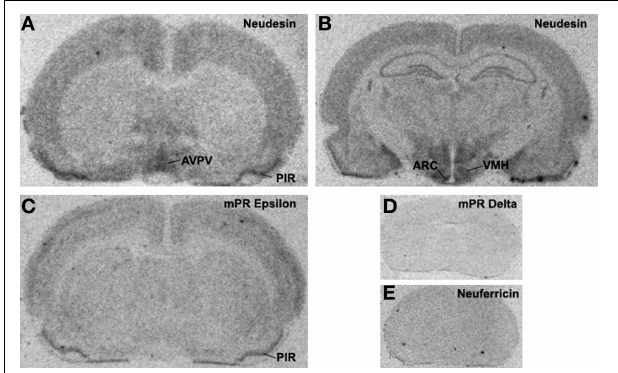
FIGURE 1 | X-ray film autoradiograms showing results of in situ hybridization studies. Twelve-micron coronal frozen sections were hybridized to 33 P-dATP end-labeled antisense deoxynucleotide probes for neudesin (Panels A and B ), mPR ε (Panel C ), mPR δ (Panel D ) or neuferricin (Panel E ). Hybridization was as described previously (Intlekofer and Petersen, 2011) and sections were placed against Kodak BioMax MR film (Rochester, NY) for 2